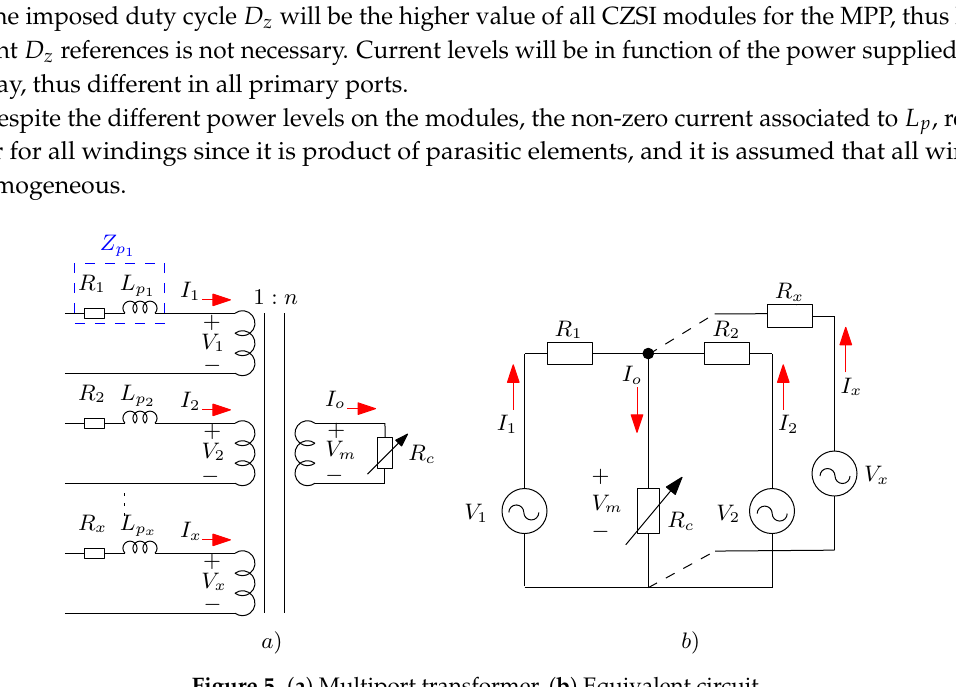
Figure 5. ( a ) Multiport transformer, ( b ) Equivalent